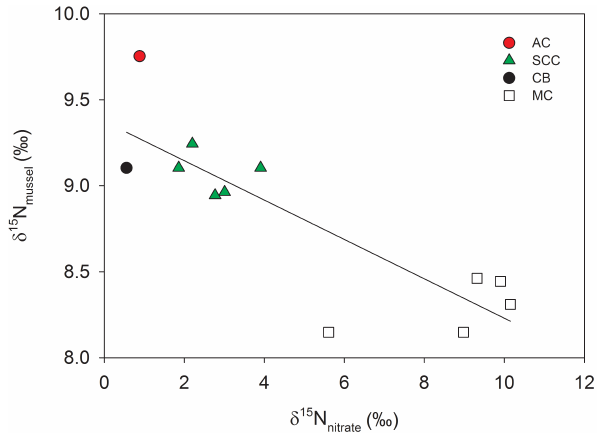
Figure 8. Relationship between nitrogen stable isotope signature of mussel and nitrate in the water ( r 2 = 0 . 711, y =− 0.114x +